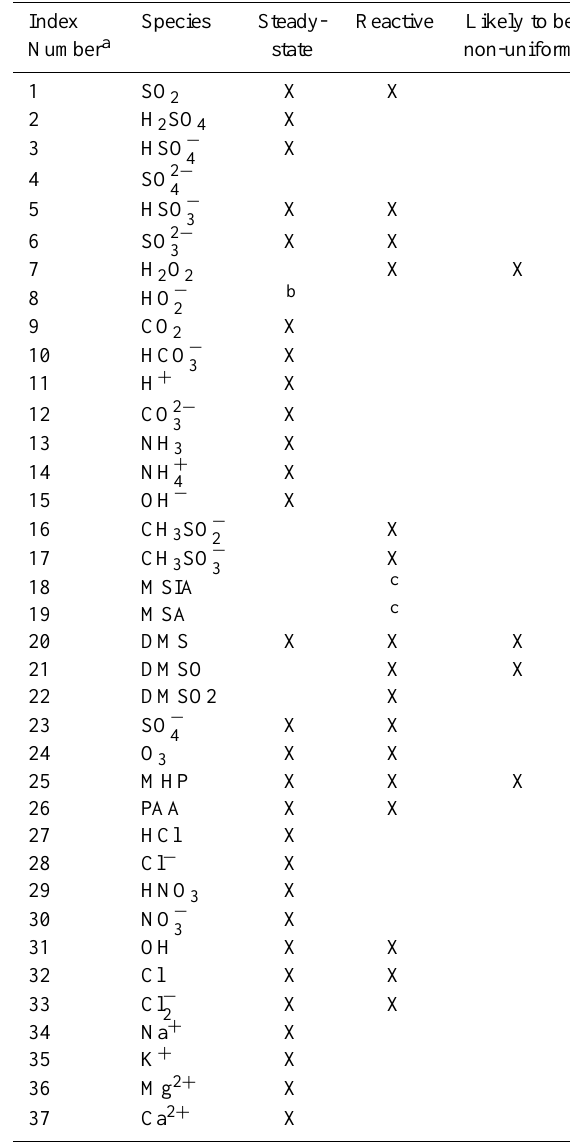
Table 6. Species treated in the revised CMAQ cloud